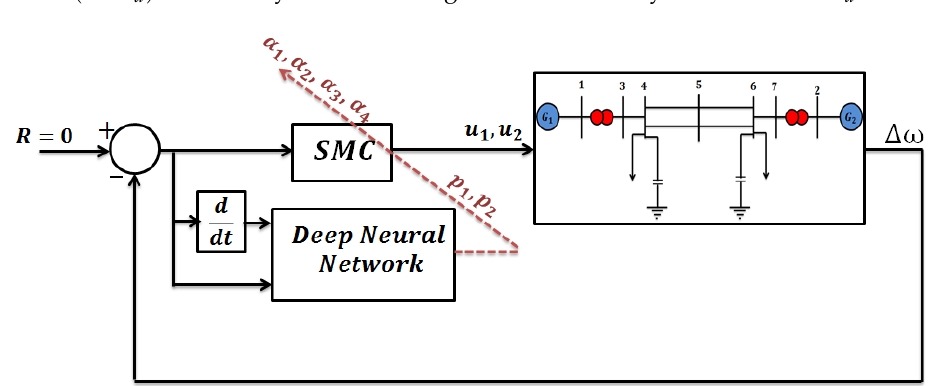
Figure 4. Structure of a DNN to the online calculation of SMC parameters.